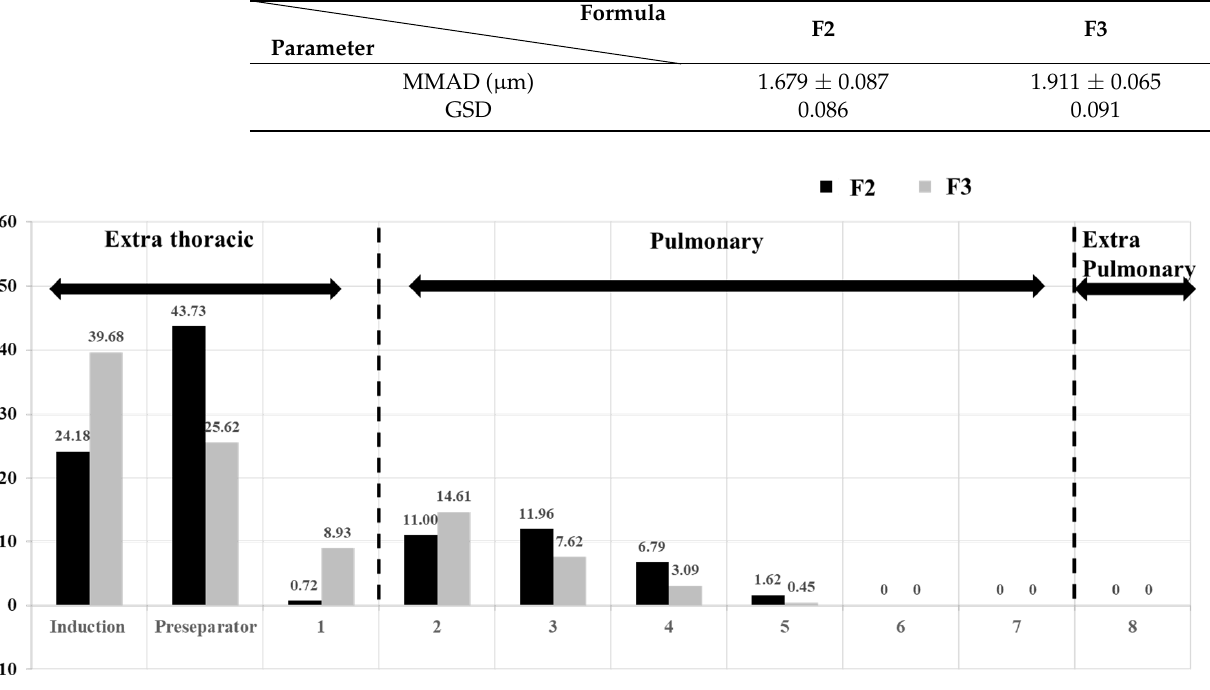
Table 6. MMAD and GSD results for the two TQ -loaded poly(ester amide)s based on L-arginine nanoparticles.